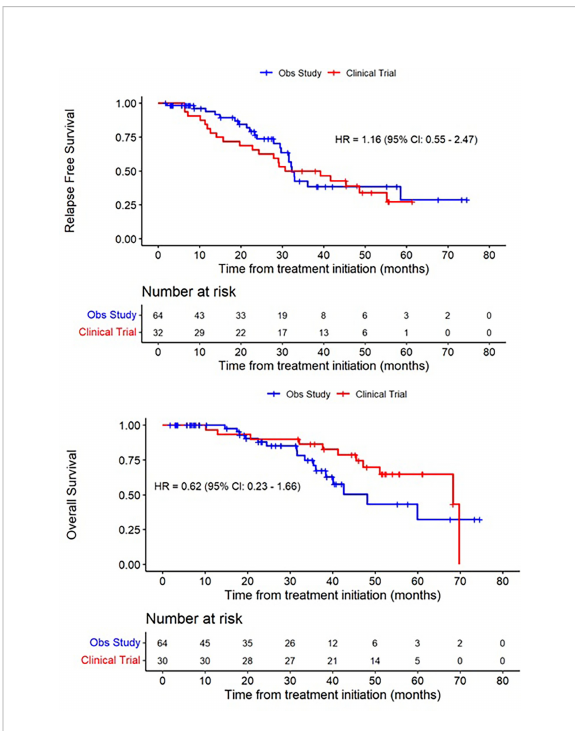
FIGURE 2 Recurrence-free Survival and Overall Survival of treated patients (red), compared to a synthetic control arm (blue).